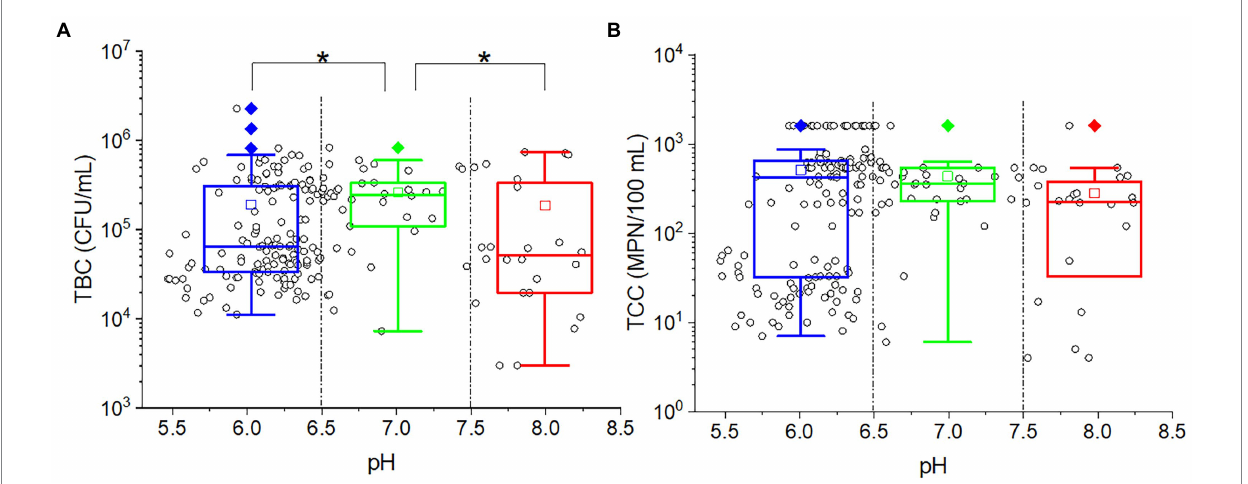
FIGURE 5 The relationship between (A) TBC [or (B) TCC] and pH. The cycles in the plots represent the measured data of each sample. The star (*) stands for there was a significant difference between the two concentrations ( p < 0.05). Different colors stand for different pH values in the effluent. The central line and square of each box are the median and mean values, respectively, while the top and bottom of each box represent the third and first quartile, respectively. Whiskers on the box plot represent maximum and minimum values, while rhombuses above or below the box plots show outliers in the data.